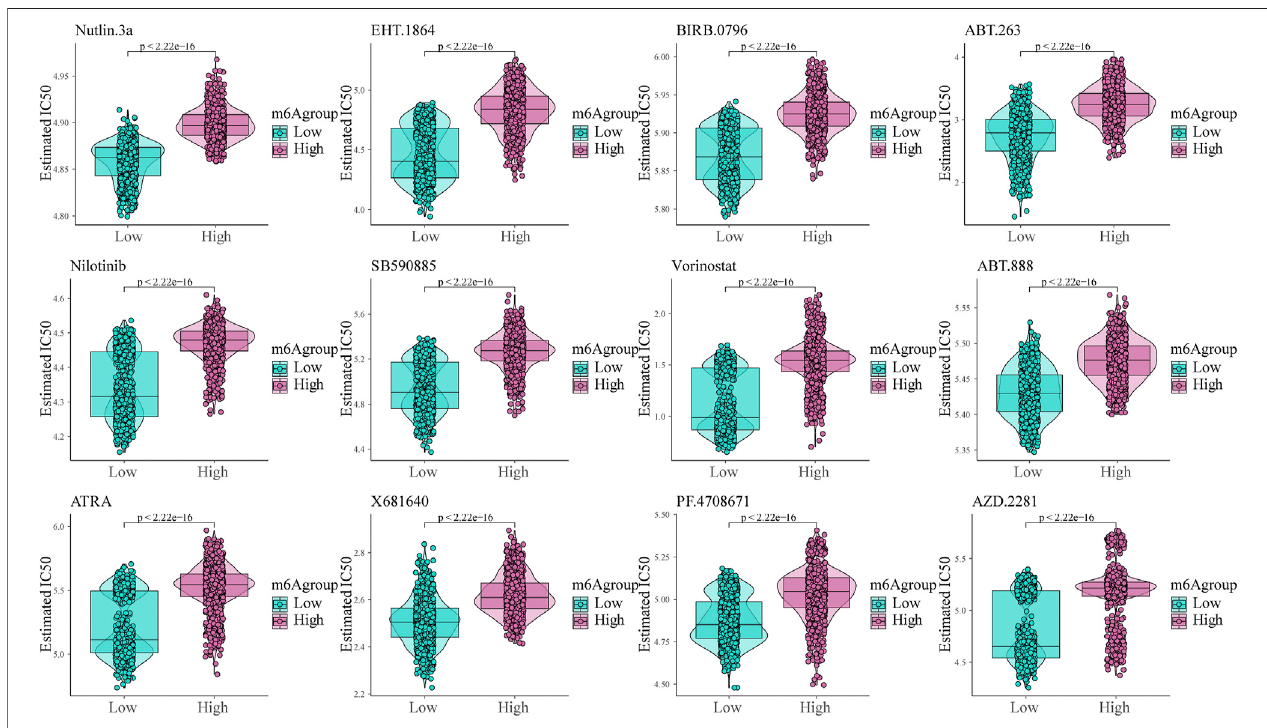
FIGURE 8 | Shows the sensitivity of the m6A risk score to different chemotherapeutics and small-molecule anti-cancer drugs based on the Genomics of Drug Sensitivity in Cancer database.